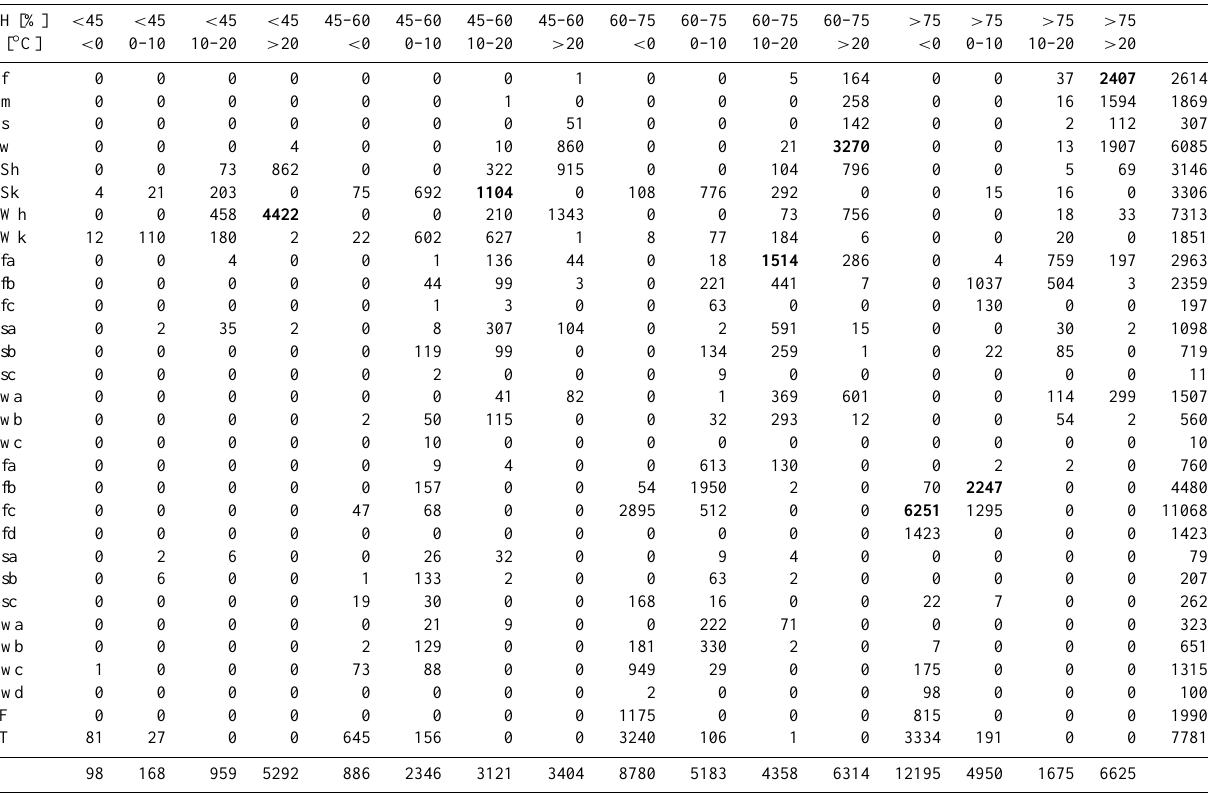
Table 1. Correspondence between Fig. 2a and b expressed by the number of 0.5 degree cells overlapping each class in the K¨oppen-Geiger and bivariate classification. The last row and column represent the total sum for each classification class. Note that these numbers are not optimized values since the number of bivariate classes (16) and the temperature and relative humidity limits are chosen arbitrary. Bold values indicate which value is largest for each row and column simultaneously. Antarctica is omitted from the